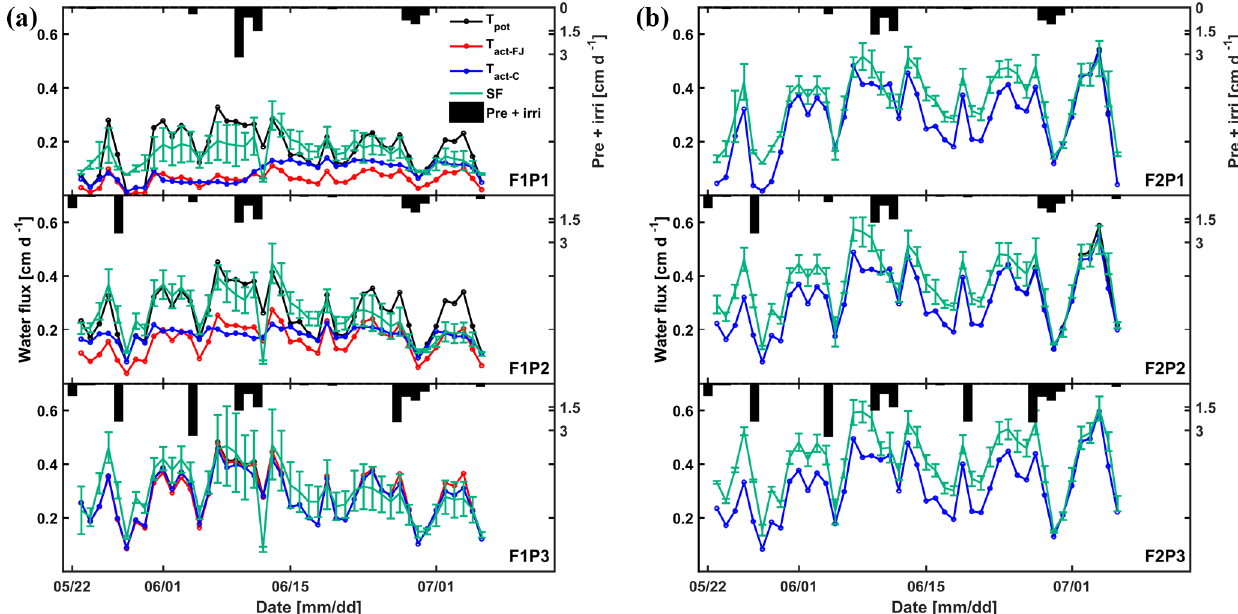
Figure 10. Daily cumulative potential transpiration ( T pot ), root water uptake ( T act = RWU) simulated by the Feddes–Jarvis (FJ) and Cou- vreur (C) models, and sap flow (SF) in the three plots (P1: sheltered; P2: rainfed; P3: irrigated) of (a) the stony (F1) and (b) silty (F2) soils from 23 May to 6 July 2014. The curves of T pot , T act-FJ , and T act-C overlapped in (b) . Pre: precipitation; irri: